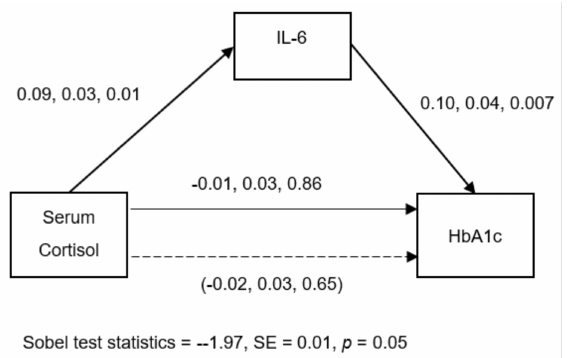
Figure A2. Mediation analysis of chronic inflammation (measured by interleukin-6, IL-6) on the association between serum cortisol levels and glycaemia